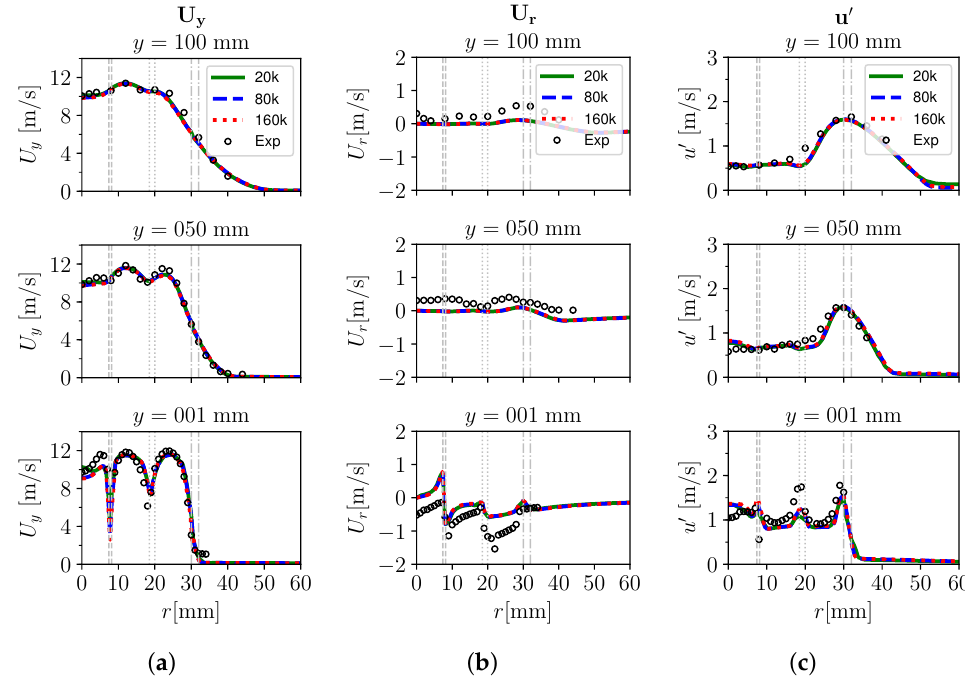
Figure A1. Case A-i2: radial distributions of mean axial velocity U y ( a ), mean radial velocity U r ( b ) and mean turbulence intensity u (cid:48) ( c ) computed at various axial positions ( y = 1, 50 and 100 mm) with different mesh resolutions (20k, 80k and 160k cells) in comparison with experimental data.